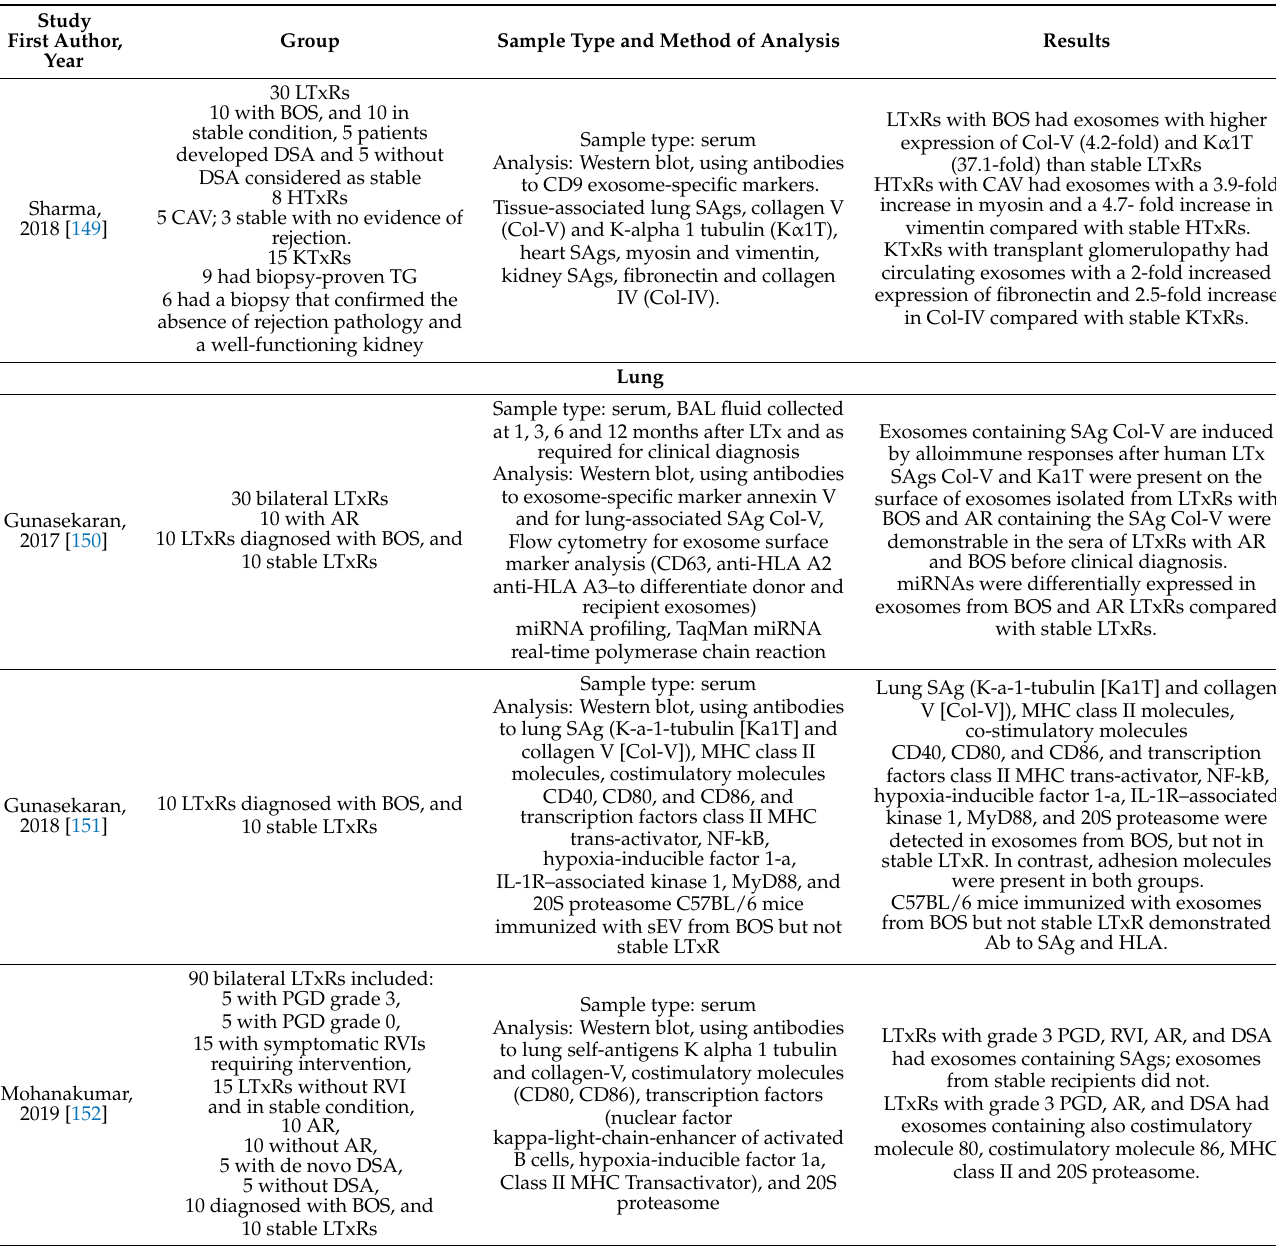
Table 1. Findings of pre-clinical studies on the use of exosomes as a biomarker for various clinical conditions in solid organ or tissue